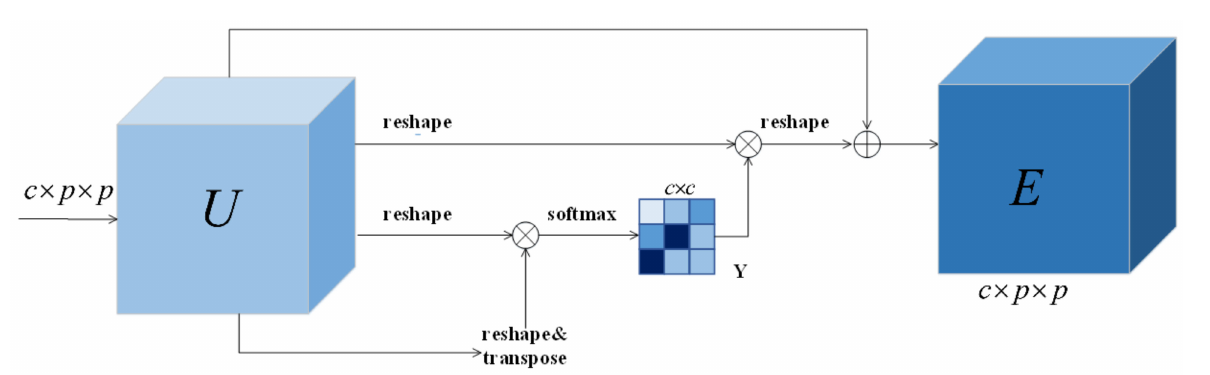
Figure 2. The schematic diagram of spectral self-attention